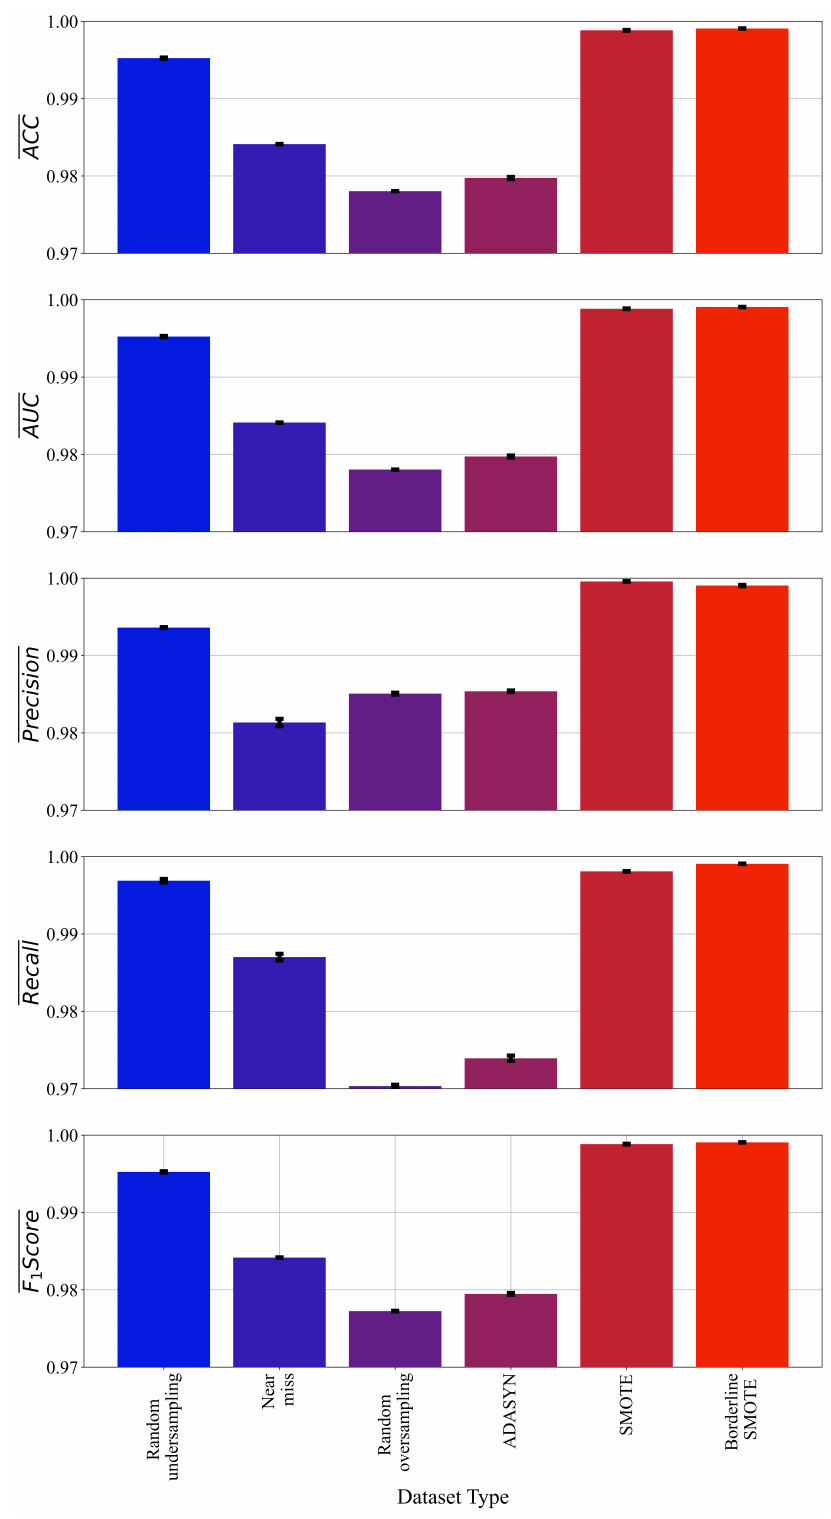
Figure 5. The mean and standard deviation of ACC , AUC , Precision , Recall , and F 1- score values achieved with GPSC, random hyperparameter search, and 5-fold cross-validation on each dataset variation. (The standard deviation is shown in the form of error